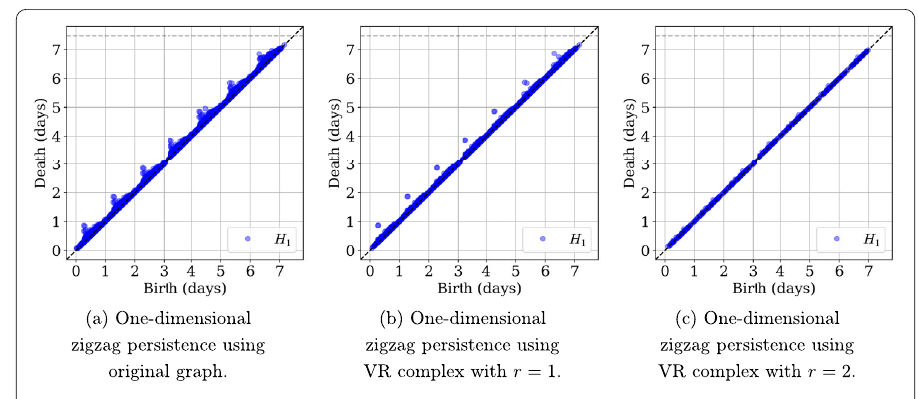
Figure 8 Zigzag persistence diagrams of the coach transportation network of Great